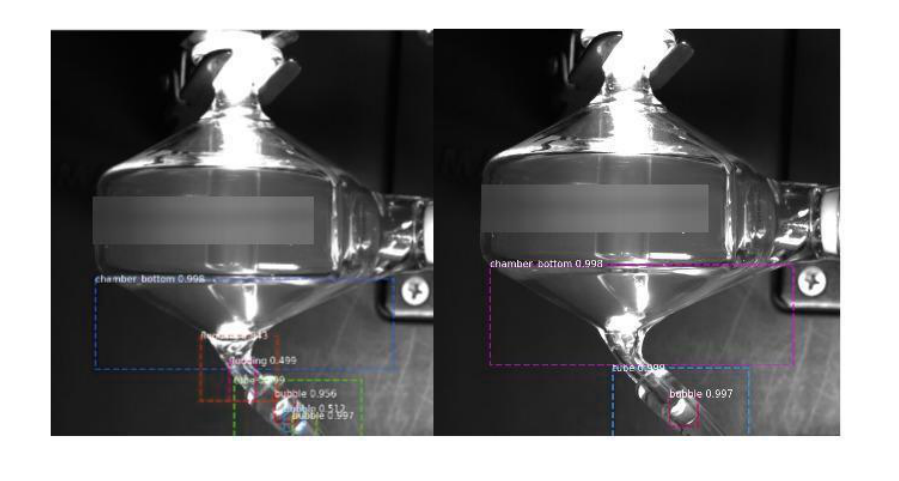
Figure 8. The bounding boxes generated by the flooding detection model. The image on the left side contains flooding, while the image on the right side does not contain flooding.